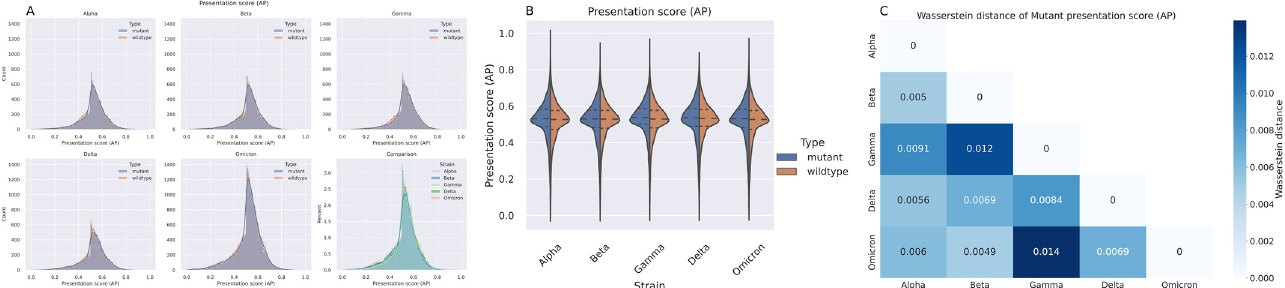
Figure 1. Comparisons of the distribution of antigen presentation (AP) scores for each SARS-COV-2 variant of concern (VOC) for the mutated and corresponding wildtype peptides. The AP scores have been filtered such that only peptides with AP scores >0.5 in either the mutant or corresponding wildtype are shown. ( A ) Histogram with a kernel density estimate of the distribution of AP scores for the mutant and wildtype peptides for each VOC. The subfigure “Comparison” shows the percentage of AP scores in each bin for all VOCs. ( B ) Violin plots of the AP score distribution between mutant and wildtype peptides for each VOC. The dashed lines within each violin plot represent quartiles. ( C ) The pairwise Wasserstein distance between the distribution of AP scores for the mutated peptides in the VOCs.